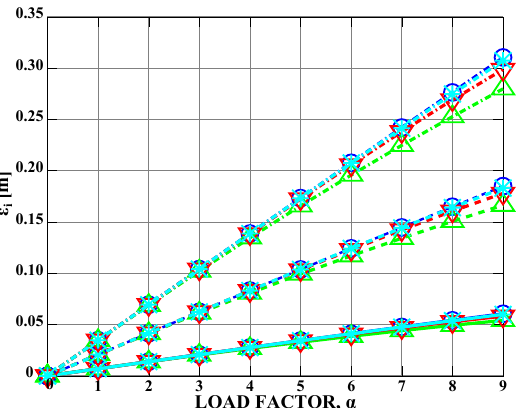
(solid line), κ ∗ 1 2